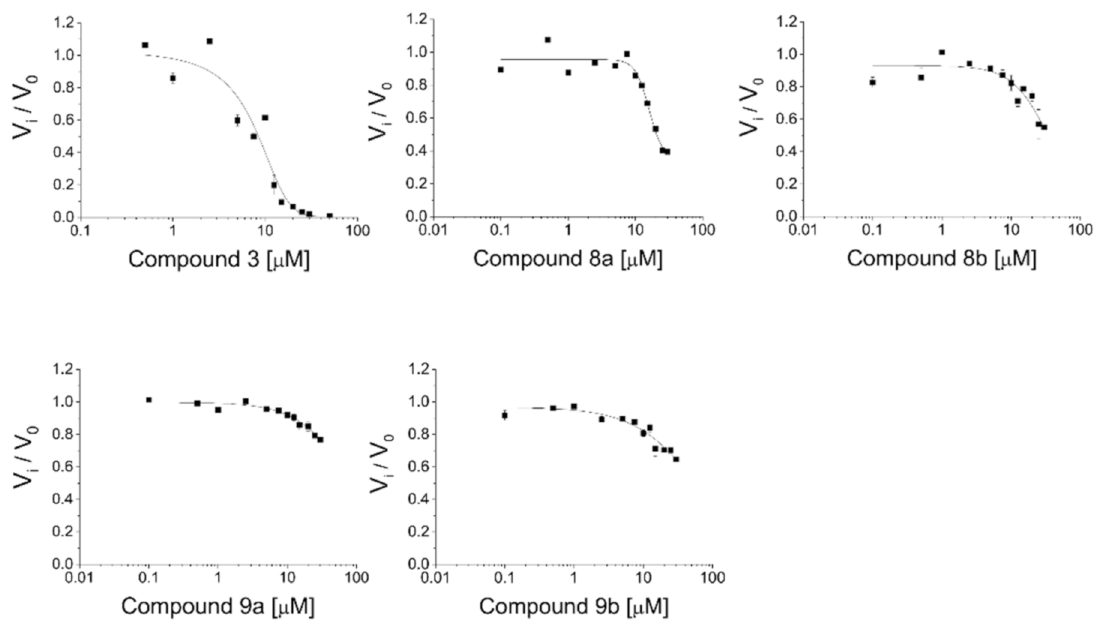
Figure 3. Determination of the IC 50 values with compounds 3 , 8a , 8b , 9a and 9b . An aliquot of PTP1B enzyme was diluted in the presence of increasing concentration of the compounds. The activity of PTP1B was determined by measuring the absorbance of the sample at 400 nm, using a spectrophotometer. Data obtained were normalized respect to the control sample and analysed using a non-linear fitting software. Data showed in the figure represent the mean value ± SD ( n =